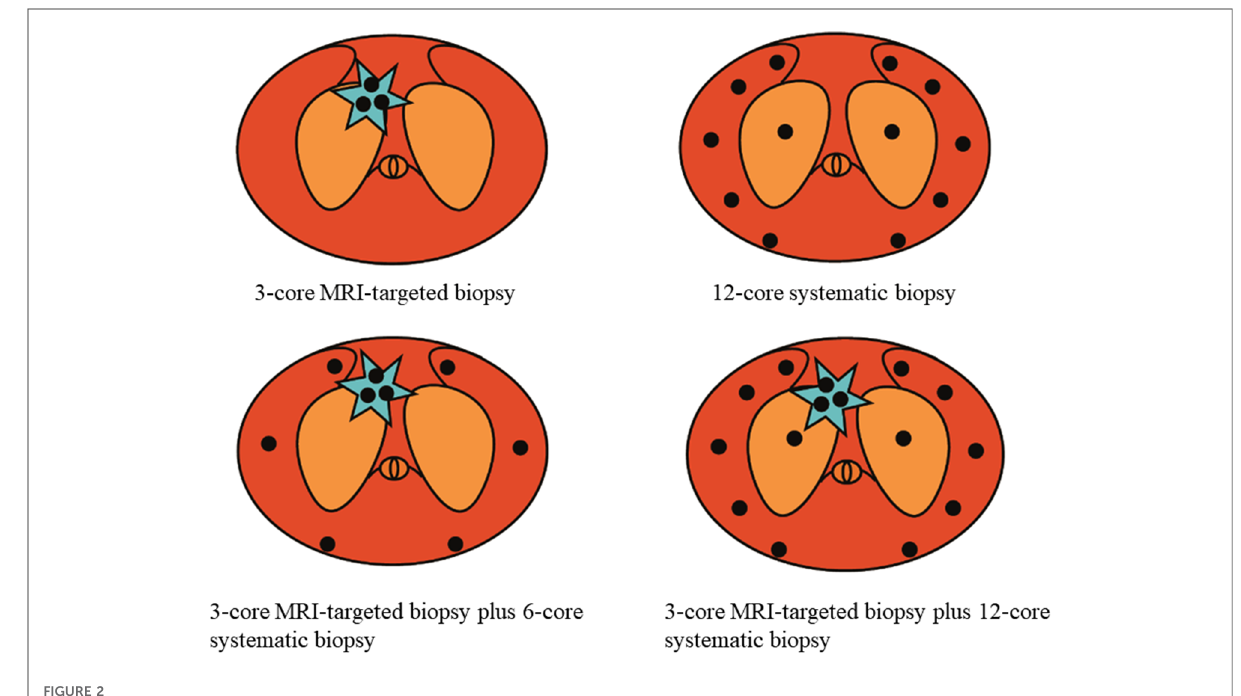
FIGURE 2 Prostate biopsy